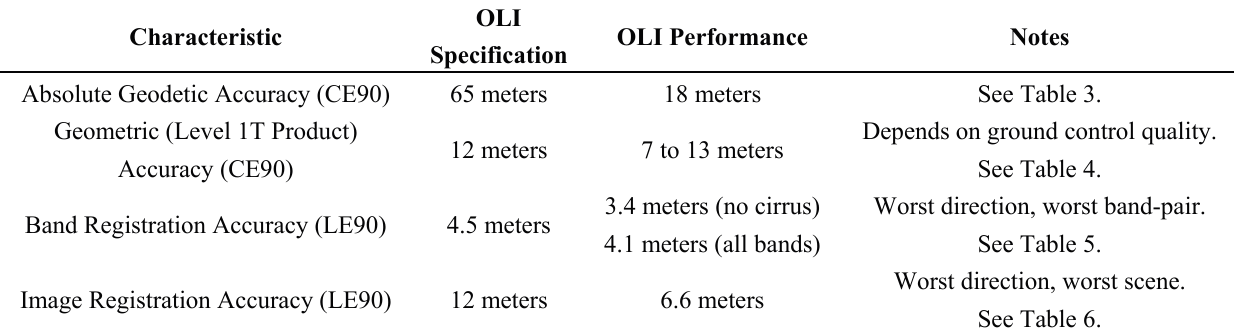
Table 7. Landsat 8 OLI geometric performance